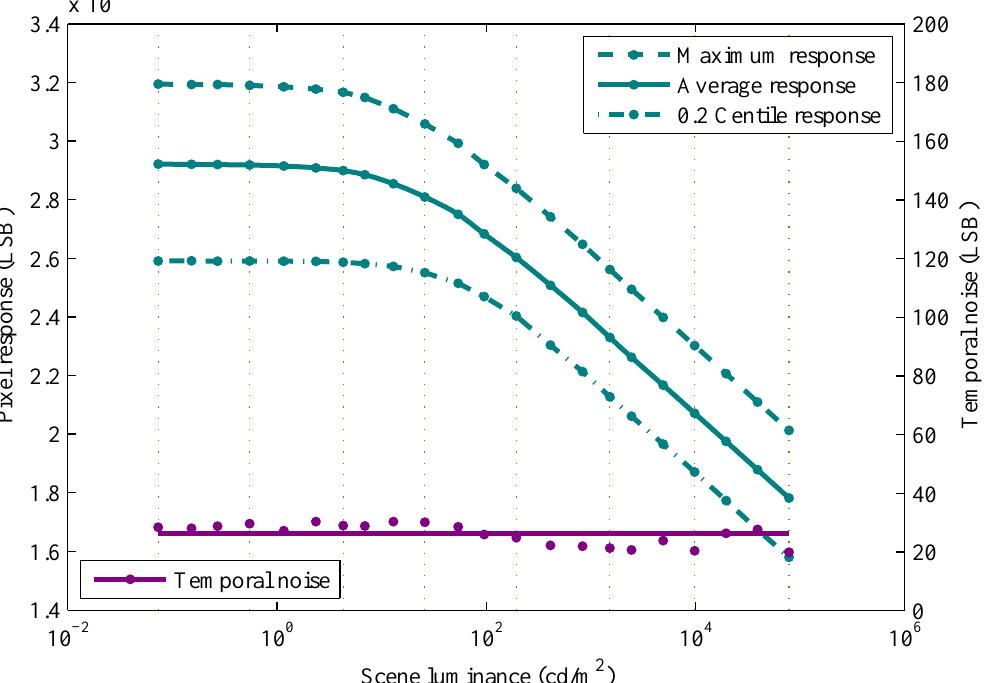
Figure 1. Statistics of a logarithmic (log) imager. The maximum response, average response, minimum response excluding outliers (<0.2% of pixels), and root mean square (RMS) temporal noise per luminance, of a 48 × 64 pixel array, are shown versus scene luminance. The overall RMS temporal noise is also shown. LSB stands for least significant